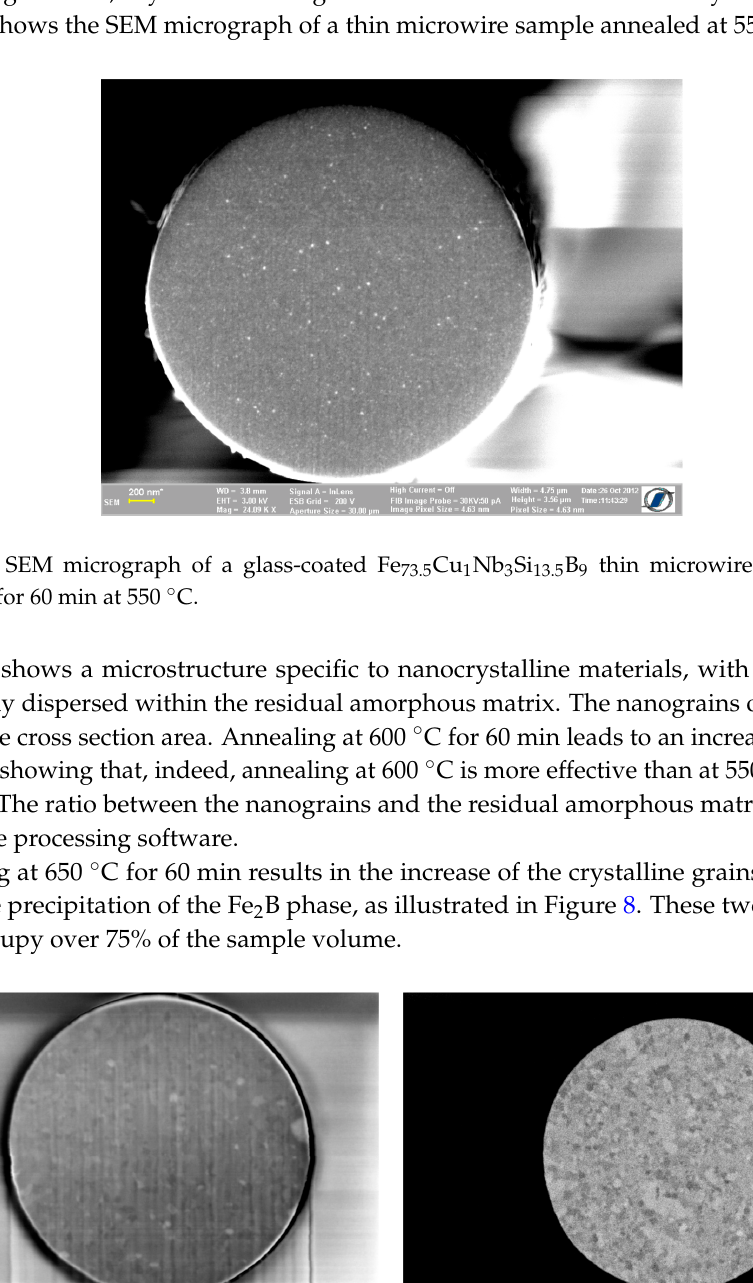
Figure 8. HR-SEM micrographs of a glass-coated Fe 73.5 Cu 1 Nb 3 Si 13.5 B 9 thin microwire sample after annealing for 60 min at 650 °C: ( a ) In-Lens detector image; and ( b ) BSE detector image.